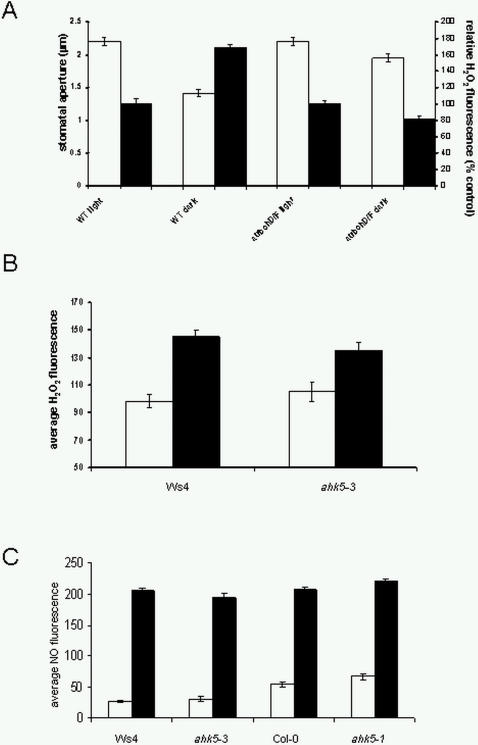
Regulation of H2O2 homeostasis by AHK5.(A) Stomatal responses to darkness in wild type (Col-0) and the atrbohD/F mutant. White bars, stomatal apertures of guard cells from leaves exposed to light (light) or transferred to darkness for 2 h (dark). Black bars, H2O2 fluorescence determined by confocal microscopy from epidermal peels exposed to light (light) or transferred to darkness for 30 min (dark). Data are expressed as mean +/− S.E. (n = 60 guard cells for aperture measurements; n = 40–80 guard cells for average H2O2 fluorescence from confocal experiments). (B) Darkness-induced H2O2 synthesis in wild type (Ws4) and ahk5-3 mutant guard cells. H2O2 fluorescence from epidermal peels exposed to ambient light (white bars) or darkness (black bars) for 30 min was determined by confocal microscopy using the H2O2-sensitive fluorescent dye H2-DCFDA. Data are expressed as mean +/− S.E. (n = 40–80 guard cells for each treatment). (C) H2O2-induced NO fluorescence from guard cells of wild type and ahk5 mutants using confocal microscopy and the NO-sensitive fluorescent dye DAF2-DA. White bars, mock-treated; black bars, 15 min treatment with 100 μM H2O2. Data are expressed as mean +/− S.E. (n = 75–130 guard cells for each treatment.